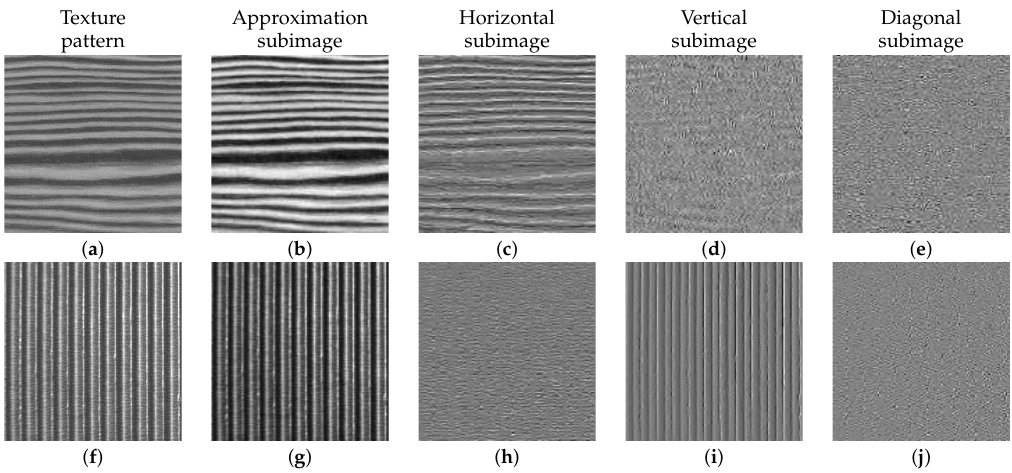
Figure 6. Texture patterns ( a , f ) and subimages of the first wavelet decomposition levels for directional textures: aproximation ( b , g ); horizontal ( c , h ); vertical ( d , i ); and diagonal ( e , j ).